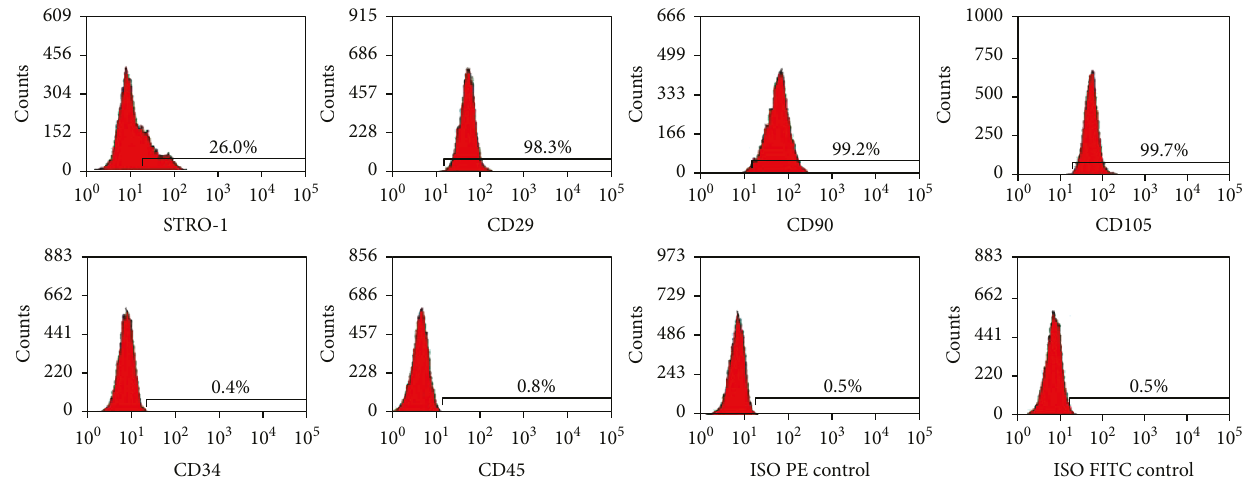
Figure 1: DPC phenotype by fl ow cytometry. The expression of a series of cell surface markers associated with the MSC phenotype was investigated using fl ow cytometry. Analysis of molecular surface antigen markers in DPCs by fl ow cytometry indicated that the cells were negative for CD34 and CD45, whereas they were positive for STRO-1, CD29, CD90, and CD105.